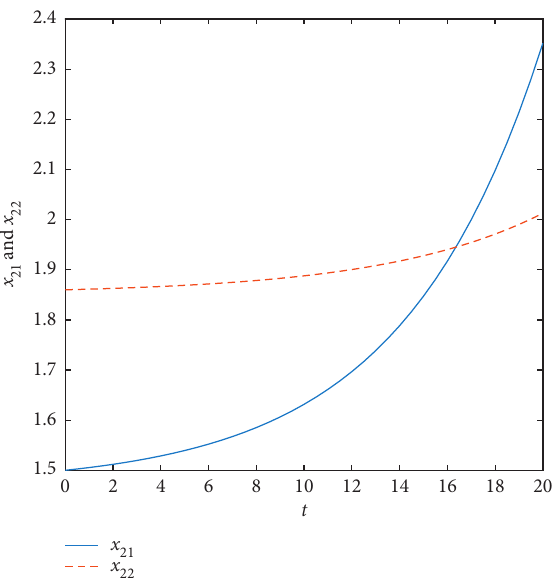
Figure 13: The pollution abatement investment trajectory of the downstream region under